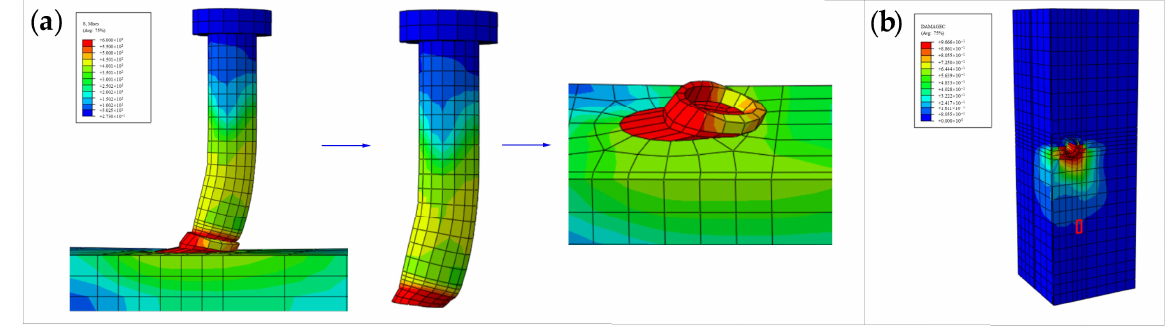
Figure 16. Stress cloud image of the specimen: ( a ) stud and welding ring; ( b ) concrete.